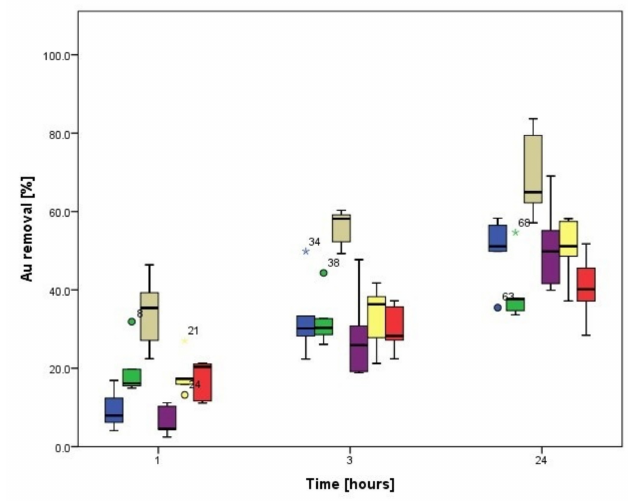
Figure 4. Au removal by 0.050 g (wet weight) of Aspergillus tabacinus pellets at different pH values and contact times. pH: (cid:4) : 2; (cid:4) : 3; (cid:4) : 4; (cid:4) : 5; (cid:4) : 6; (cid:4) : 7.